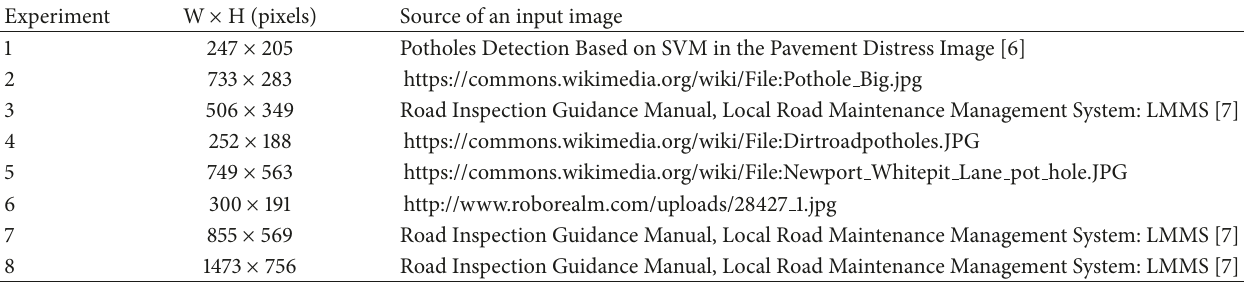
Table 1: Information of images used as inputs of our experiments as shown in Figures 4 and